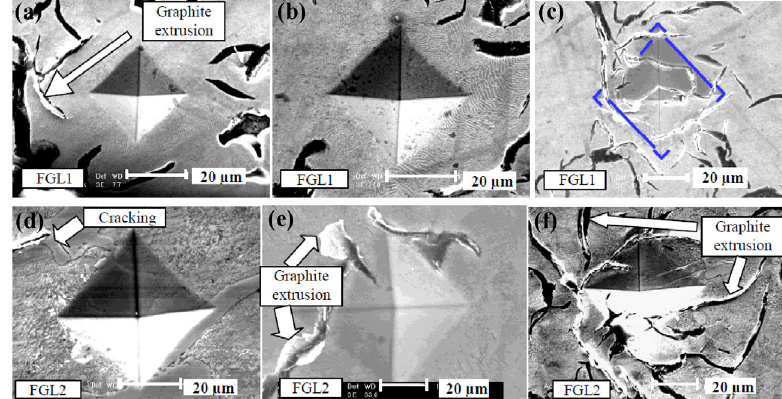
Fig. 5 Vickers indents SEM images of matrix cast iron, load test, from left to right: 100, 200 and 500 g, respectively.